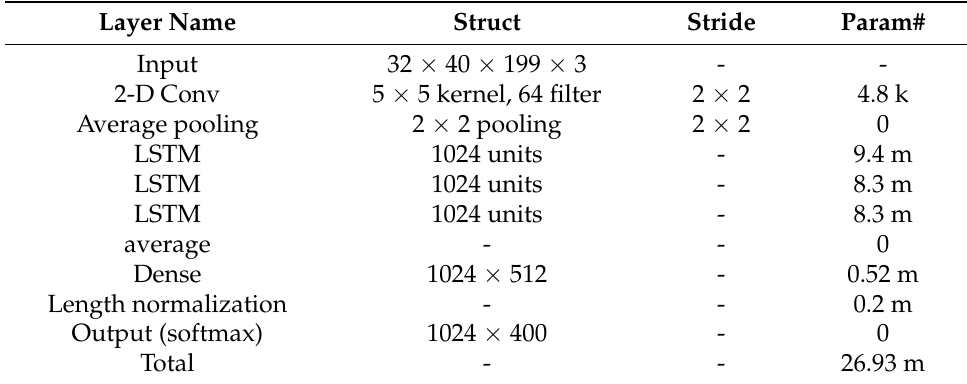
Table 5. The details on deep CNN + RNN-LSTM unit network model.